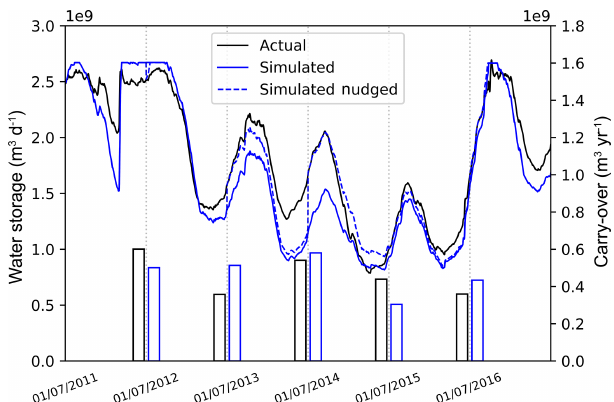
Figure 4. Actual and simulated reservoir storage and carry-over vol- umes in Blowering and Burrinjuck reservoirs